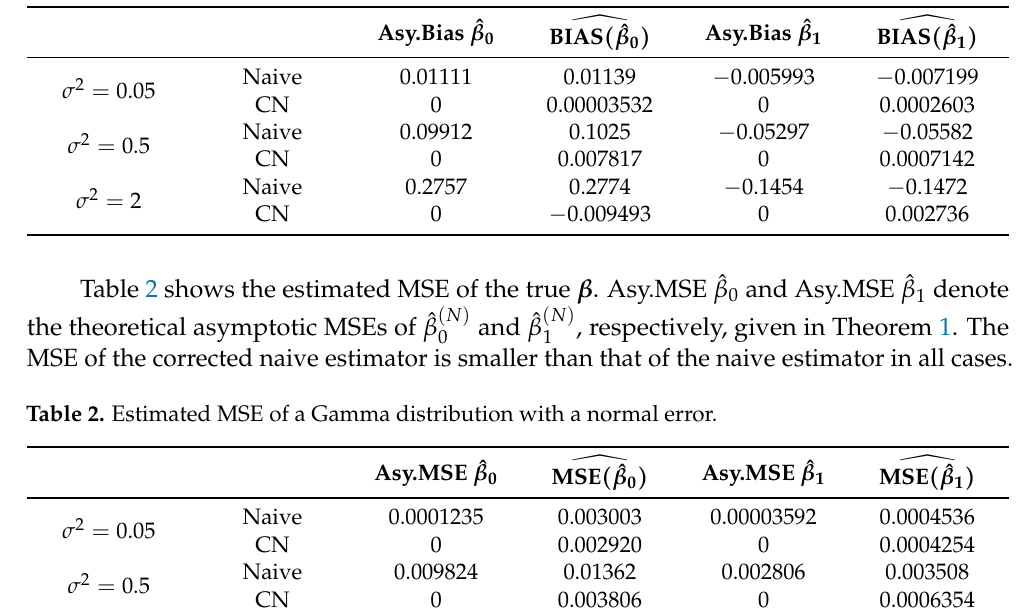
Table 1. Estimated bias of a Gamma distribution with a Normal error.